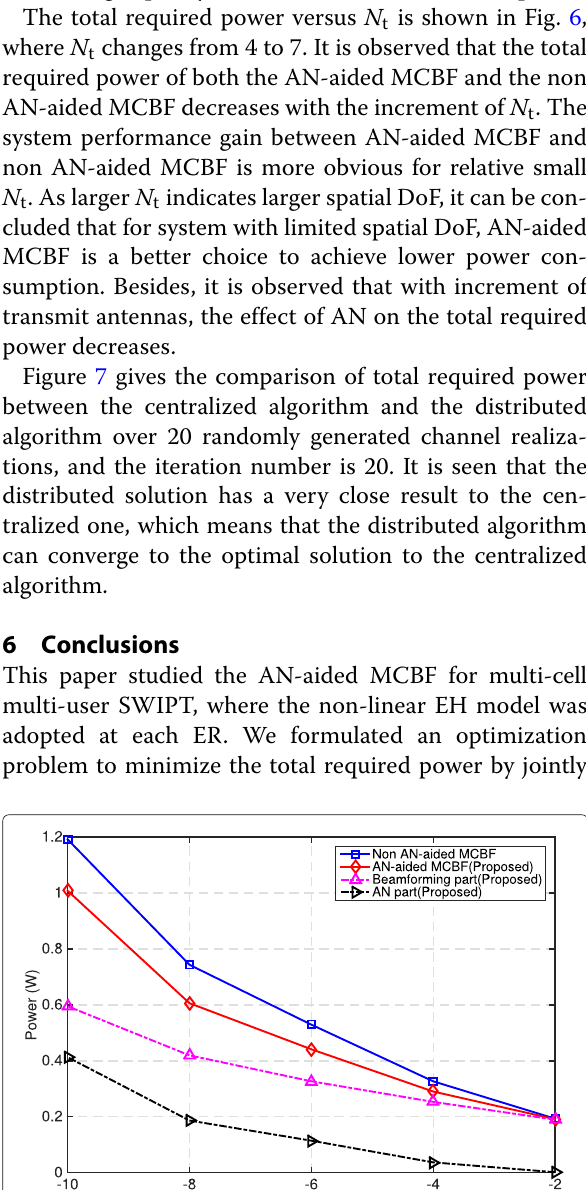
Fig. 3 Required power versus SINR requirement at each IR